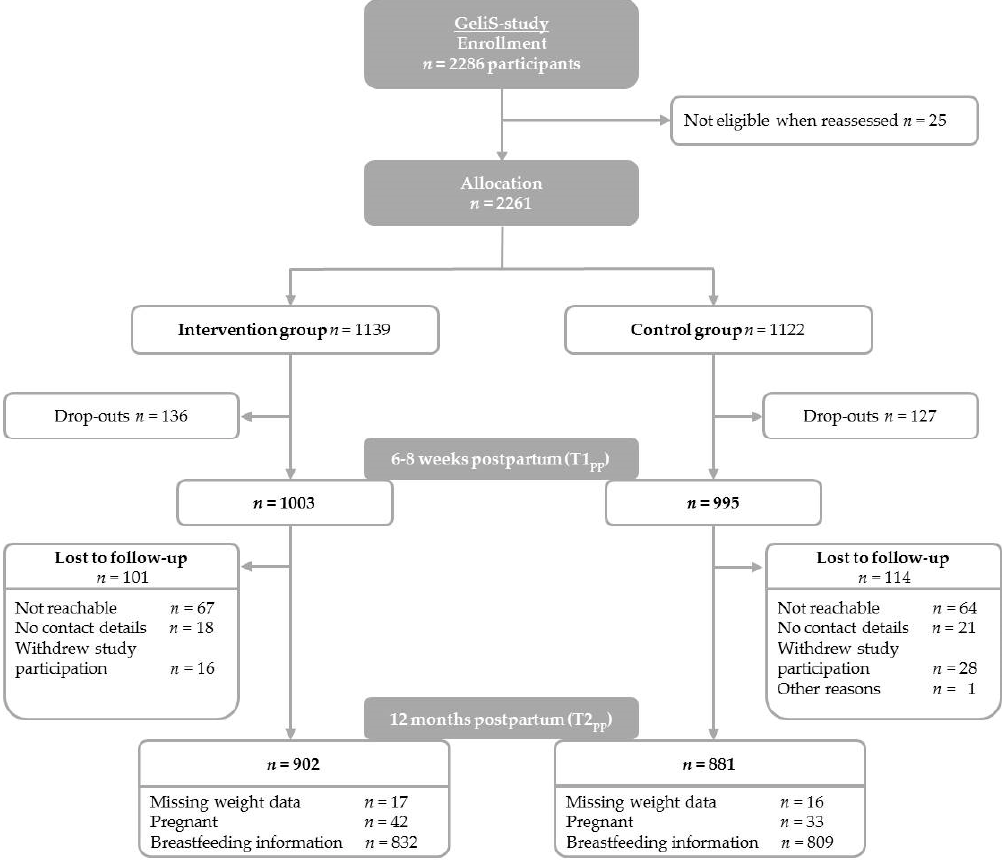
Figure 1. Participant flow.